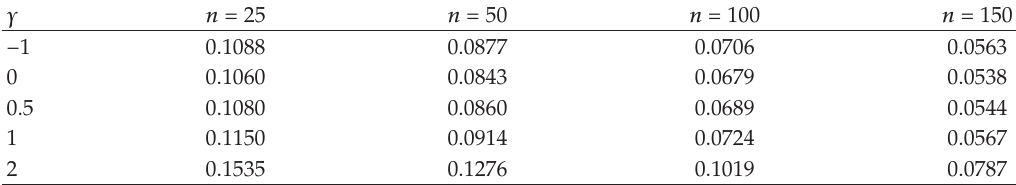
Table 9: MSE of the estimates for the exponential distribution under right censoring.